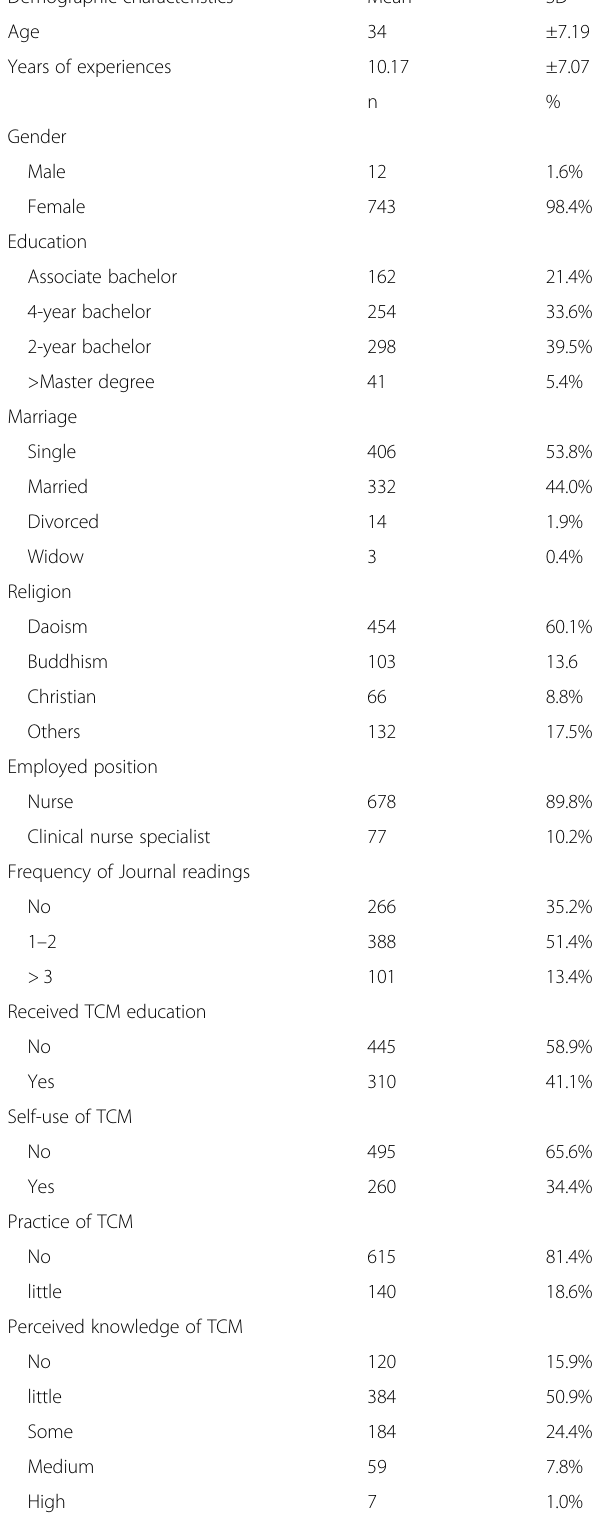
Table 1 Participants ’ demographic characteristics ( n = 755)